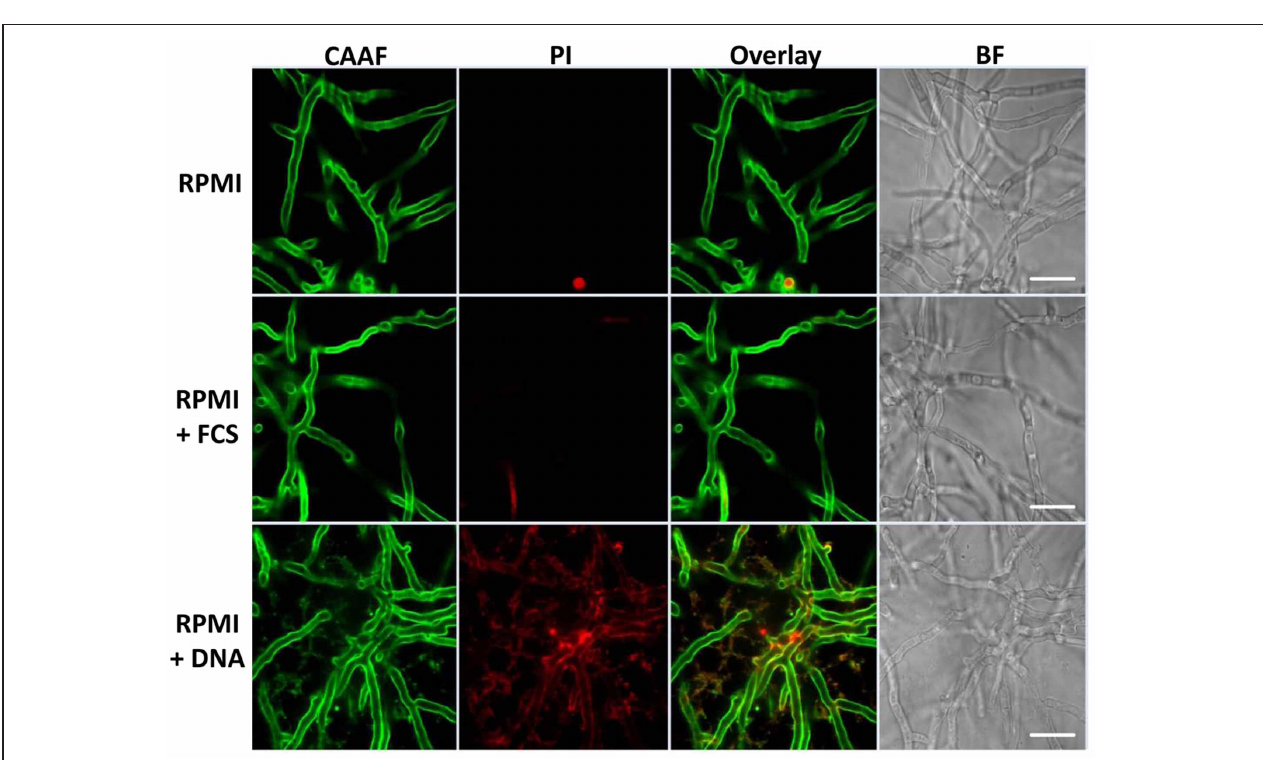
extracted DNA; pDNA; purified plasmid DNA). Displayed values represent the means and SDs of three independent experiments and an asterisks indicate p < 0 . 05 in an unpaired t -test. (B) FCS- and DNA-specific increases in total polysaccharide production are expressed as the ratio of CAAF fluorescence to biomass normalized to untreated controls.